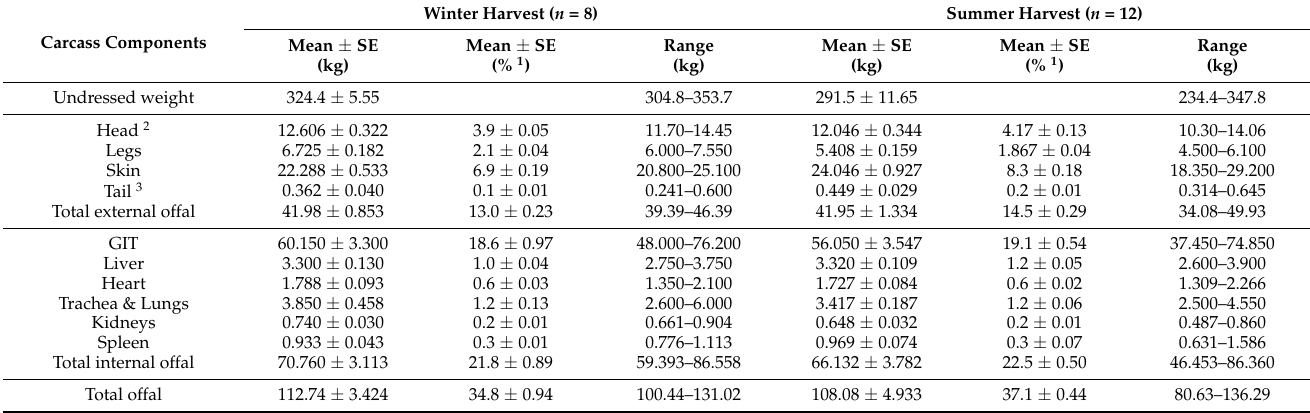
Table 3. Mean ( ± standard error), minimum and maximum of offal yields from eight Plains zebra stallions harvested in the winter season and 12 Plains zebra stallions harvested in the summer